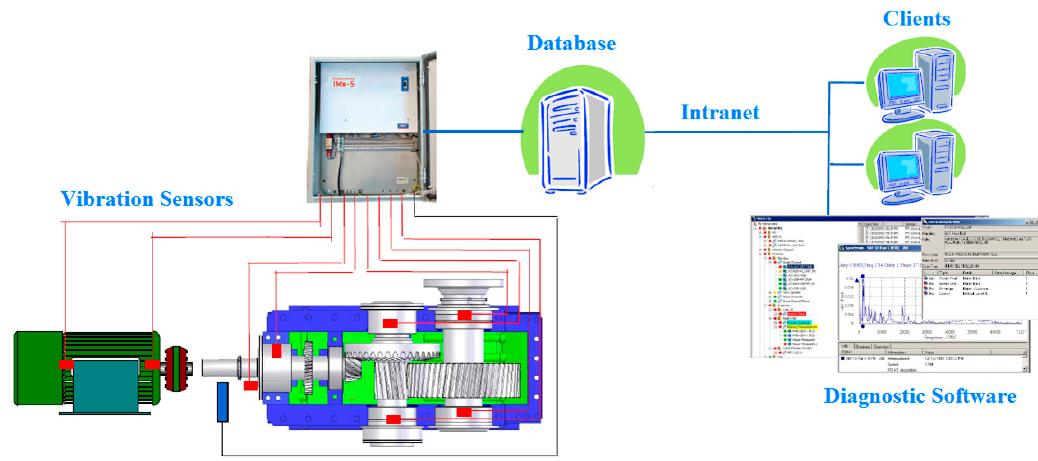
Figure 3. Predictive maintenance Potential to Functional Failure (P-F) curve.